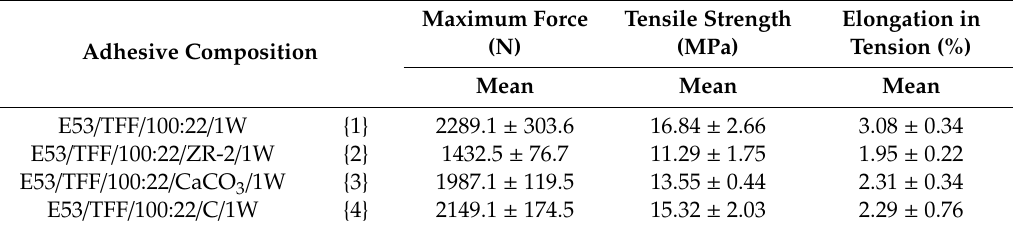
Table 7. Strength test results of the adhesive compositions from the E53 / TFF / 1 week group.